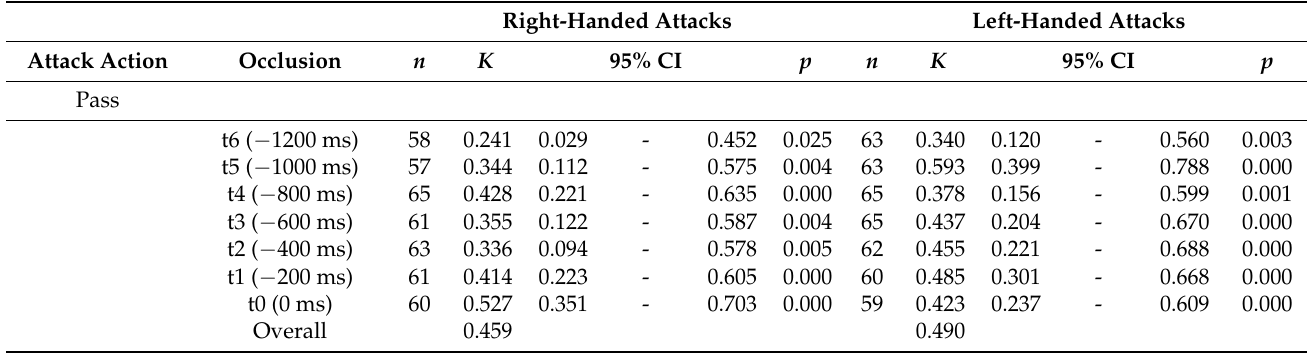
Table 1. Cont . Right-Handed Attacks